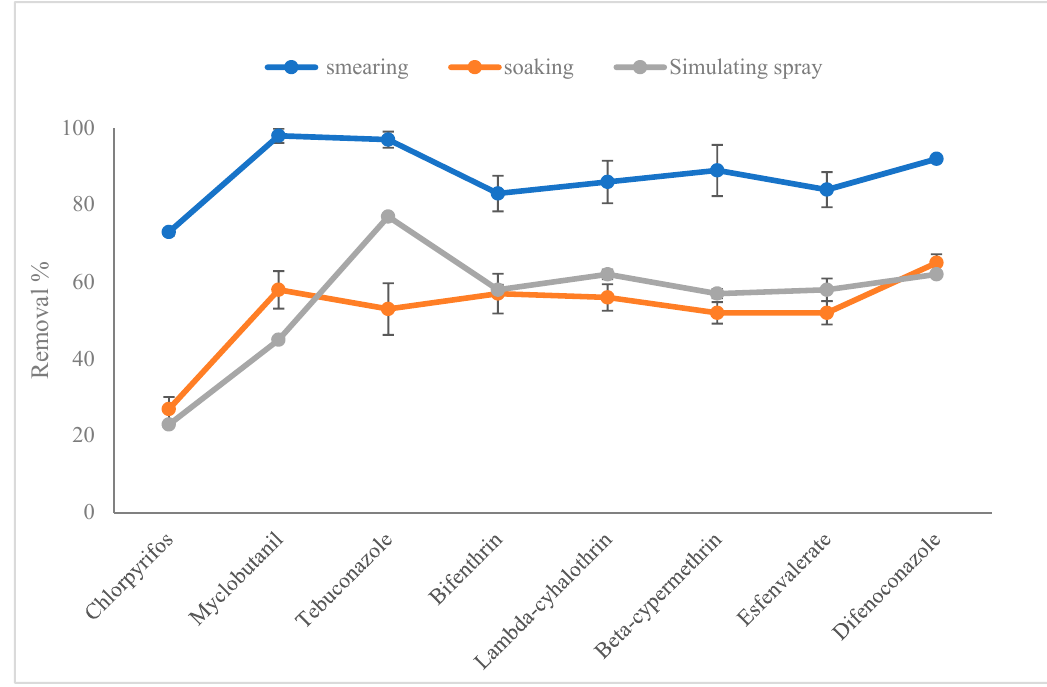
Figure 2. Removal efficiency of eight pesticides in kumquat treated with smearing, soaking, or simulating the field application by washing with 5 g micron calcium for 15min ( n = 3).